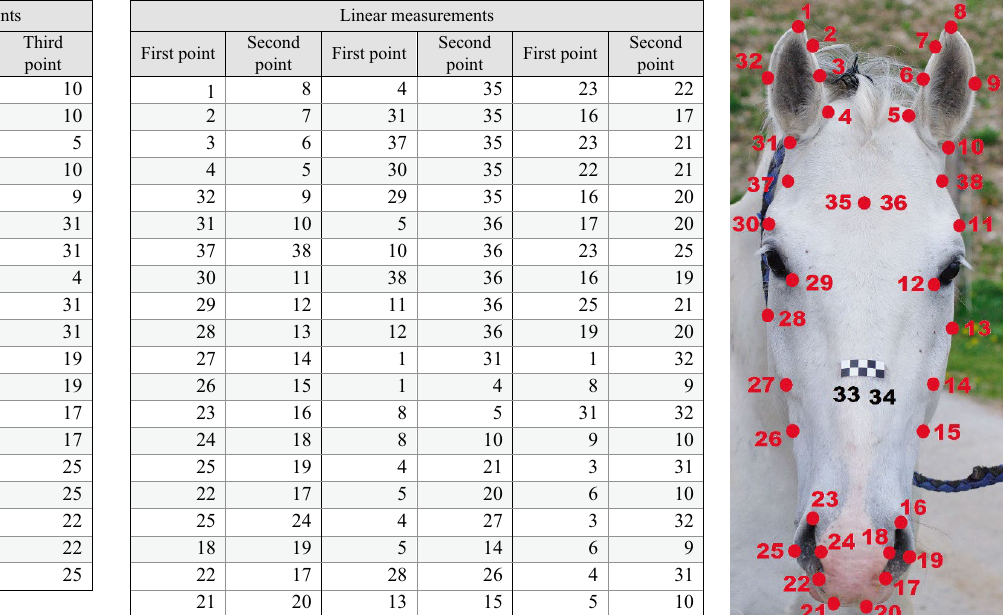
Figure 2. Detailed description of measurements, extracted from the CoordGen8 computer program. Picture of the horse front head profile on the right represents how landmarks were positioned on the horse’s head picture. Each landmark had an individual number that was consistent throughout all 35 horse pictures. Black numbers 33 and 34 were markers for unit of 1 cm (distance between them was 1 cm). Table on the left represents measurements that were extracted from landmarks. Angle measurements represent angles, measured between 3 landmark points (first point, second point and third point) marked on the horse’s head profile picture on the right, while linear measurements were actual distances between two landmark points (first point and second point) marked on the horse’s head profile picture on the